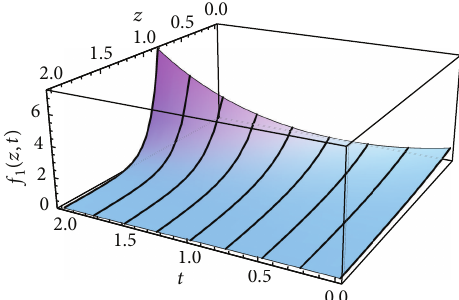
Figure 7: Plot of 𝑓 1 (𝑧, 𝑡) given by (86) in Example 16 at different values of 𝑡 = {0, 0.25, 0.5, . .. ,2} in the case that 𝑍 0 ∼ Exp (1) , 𝑡 0 = 0 , 𝑎 = −1 , and 𝑏 = 1